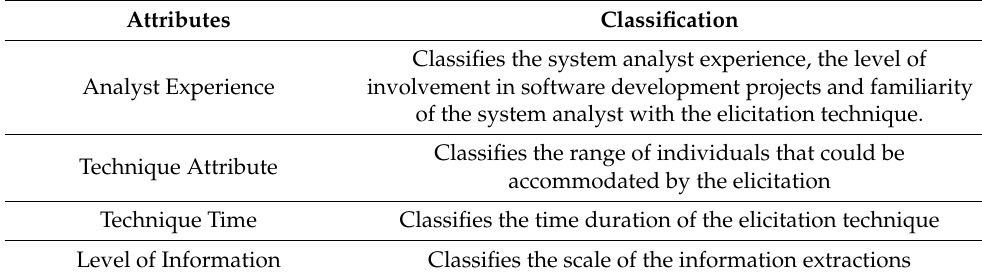
Table 1. Technique selection attributes.